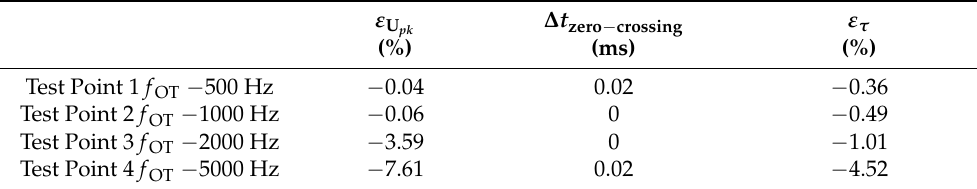
Table 12. VT PIs results under oscillatory transient